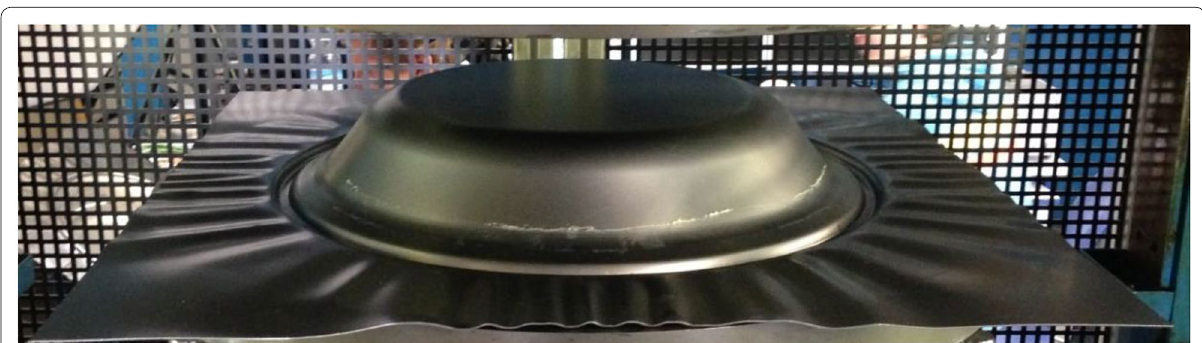
Figure 11 Physical sheet shape after conventional process from sample #B3